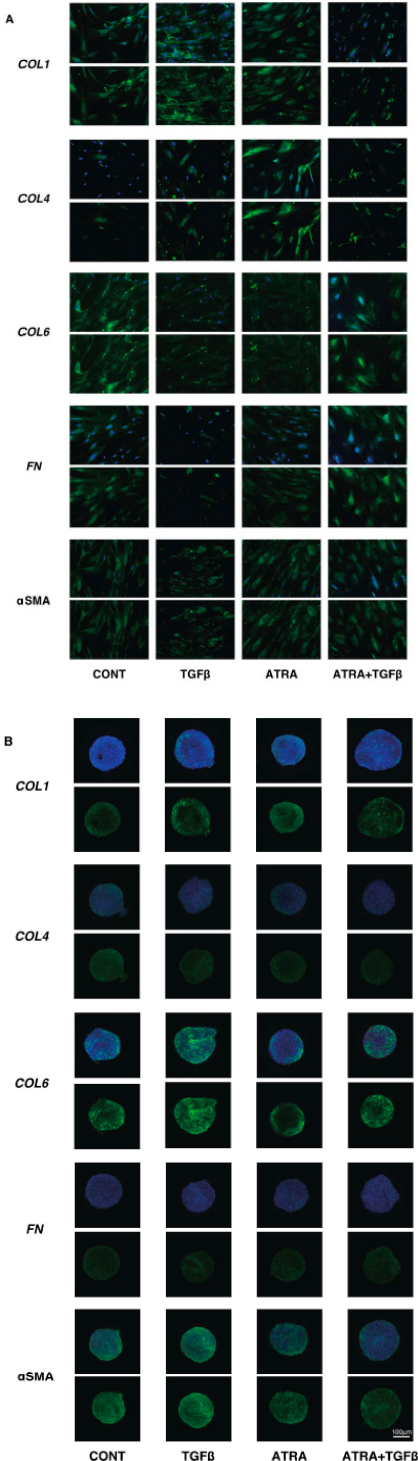
Figure 5. Effects of ATRA on the immunolabeling of ECM proteins of the TGF- β 2 untreated or treated HconF cells. Two-dimensional and three-dimensional HconF cells untreated and treated with TGF- β 2 (TGF β , 5 ng/mL) were subjected to immunolabeling for COL 1 , COL 4 , COL 6 , FN, and aSMA in the presence or absence of 1 μ M ATRA. Experiments were repeated in duplicate ( n = 5 in each). Representative images of ECM staining (lower) and the merged images with DAPI (upper) are shown in panels ( A ) (2D) and ( B ) (3D).